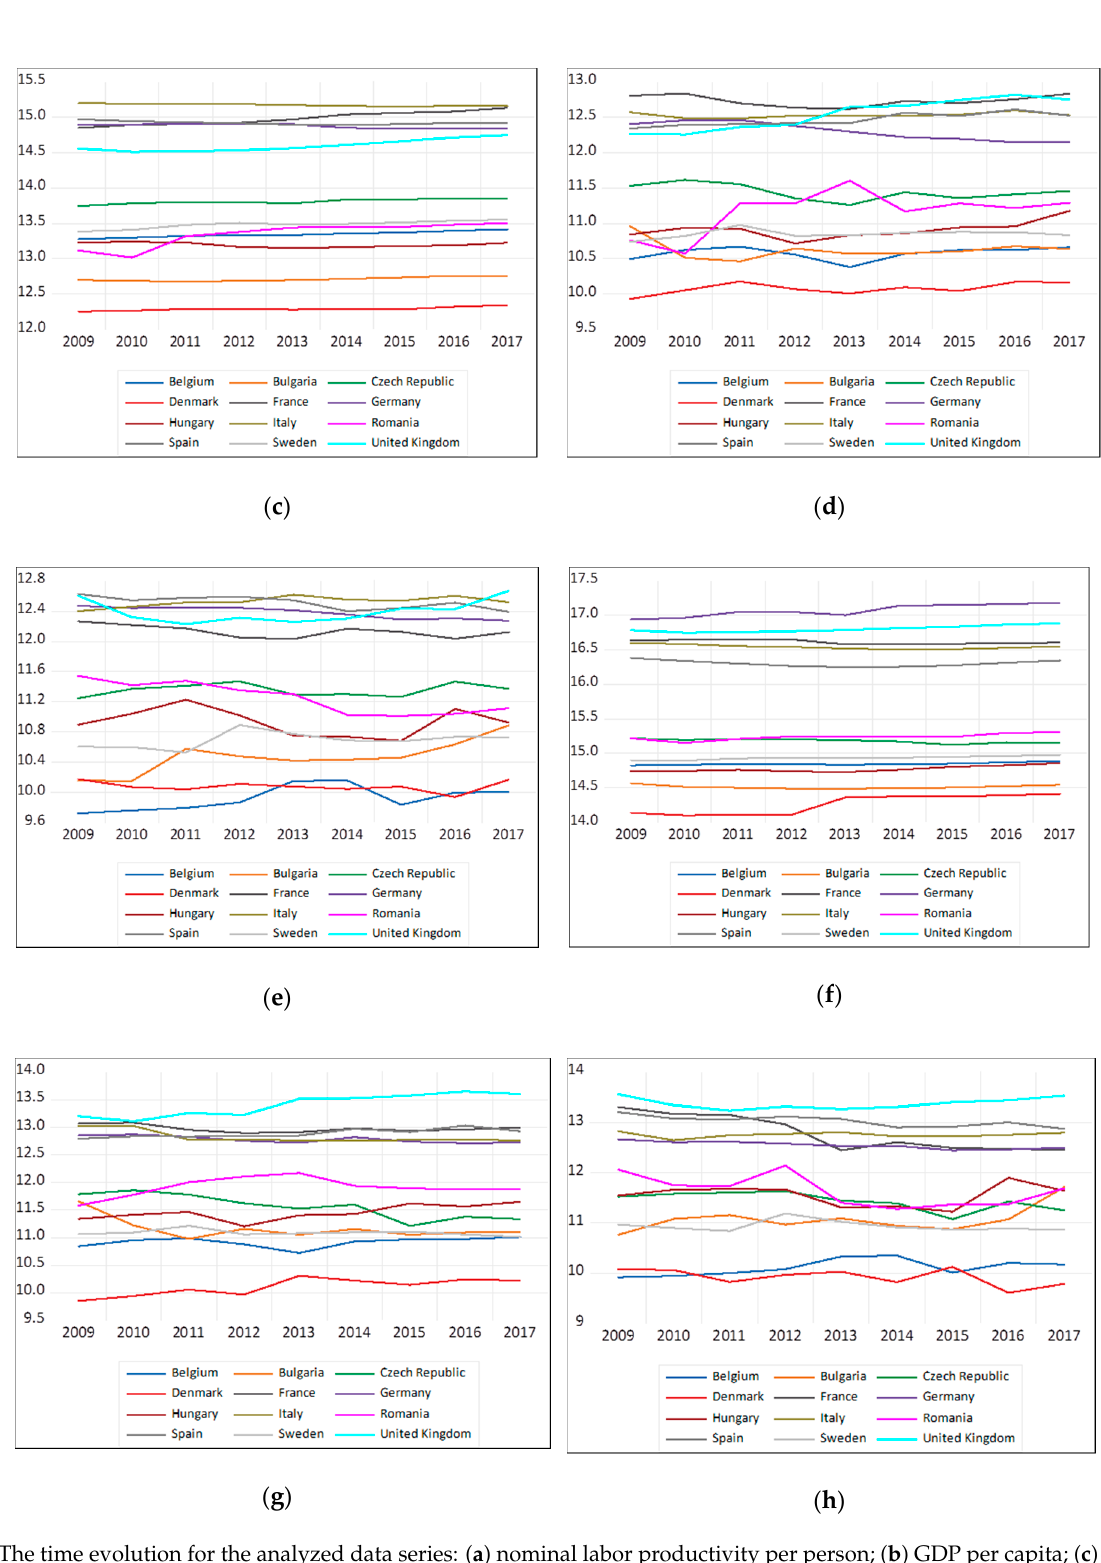
Figure 2. The time evolution for the analyzed data series: ( a ) nominal labor productivity per person; ( b ) GDP per capita; ( c ) population of active enterprises; ( d ) births of enterprises; ( e ) deaths of enterprises; ( f ) persons employed in the population of active enterprises; ( g ) persons employed in the population of births; ( h ) persons employed in the population of deaths. Source: the authors, based on Eurostat (2020).